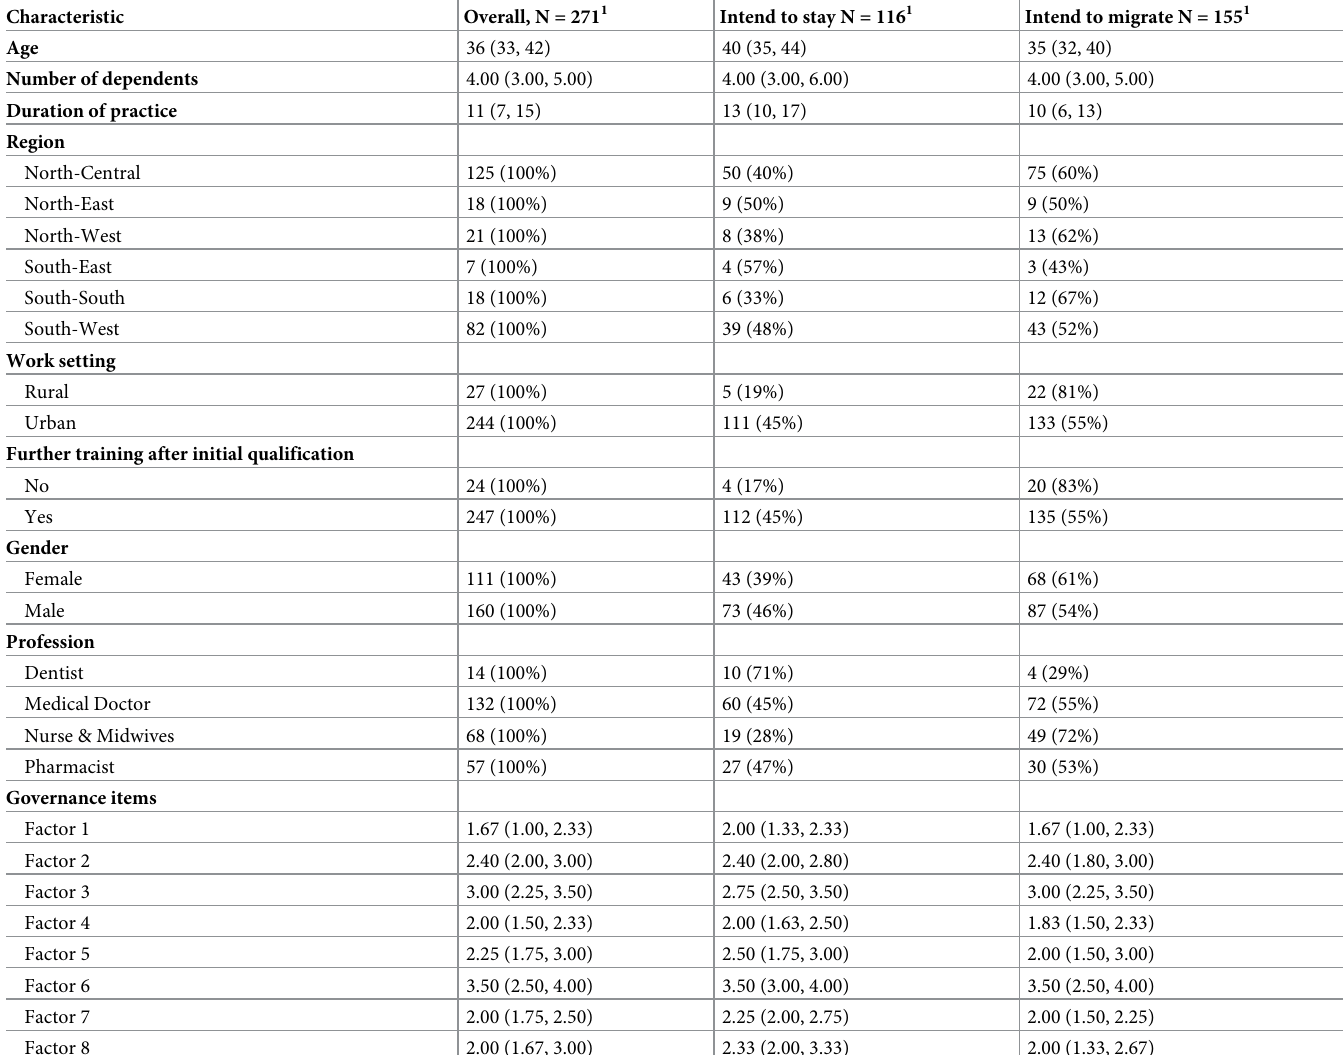
Table 1. Description of the study participants and SHW migration governance